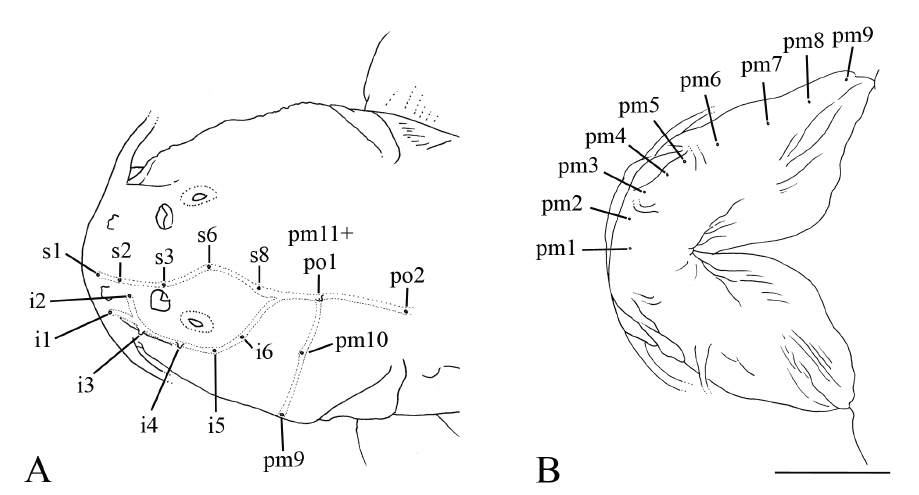
FIGURE 4 | Rhyacoglanis varii laterosensory canal pores, MZUSP 54082, 47.6 mm SL, paratype, in dorsal ( A ) and ventral views ( B ). i1 to i6 = infraorbital pores 1 to 6; pm1 to pm11 = preoperculomandubular pores 1 to 11; po1 and po2 = postotic pores 1 and 2; s1 to s8 = supraorbital pores 1 to 8. Scale bar = 5